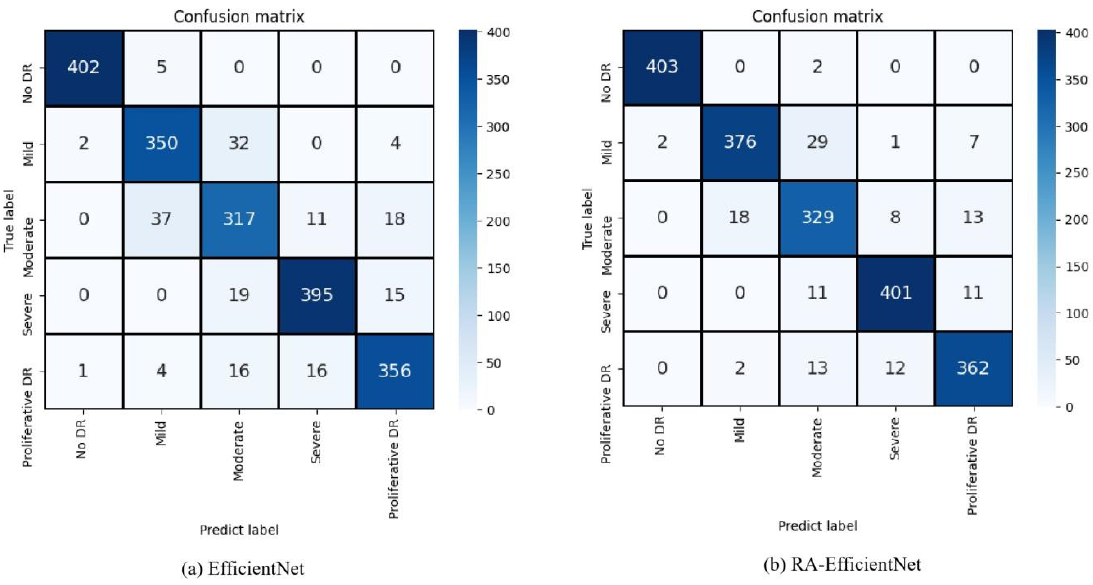
Table 8. Comparison with existing works for DR severity grades on APTOS 2019 dataset.